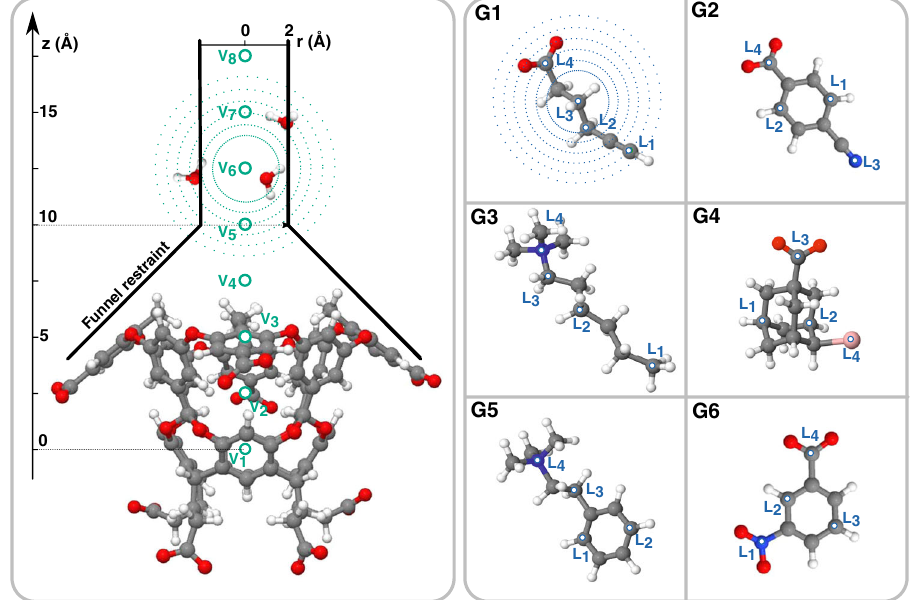
Fig. 1 Sketch of the octa-acid host OAMe with the funnel restraint geometry and the guest molecules from the SAMPL5 challenge. We indicate the position of the points where the descriptors are centred and hint at their spatial outreach by drawing surfaces at a constant radius around some of them.